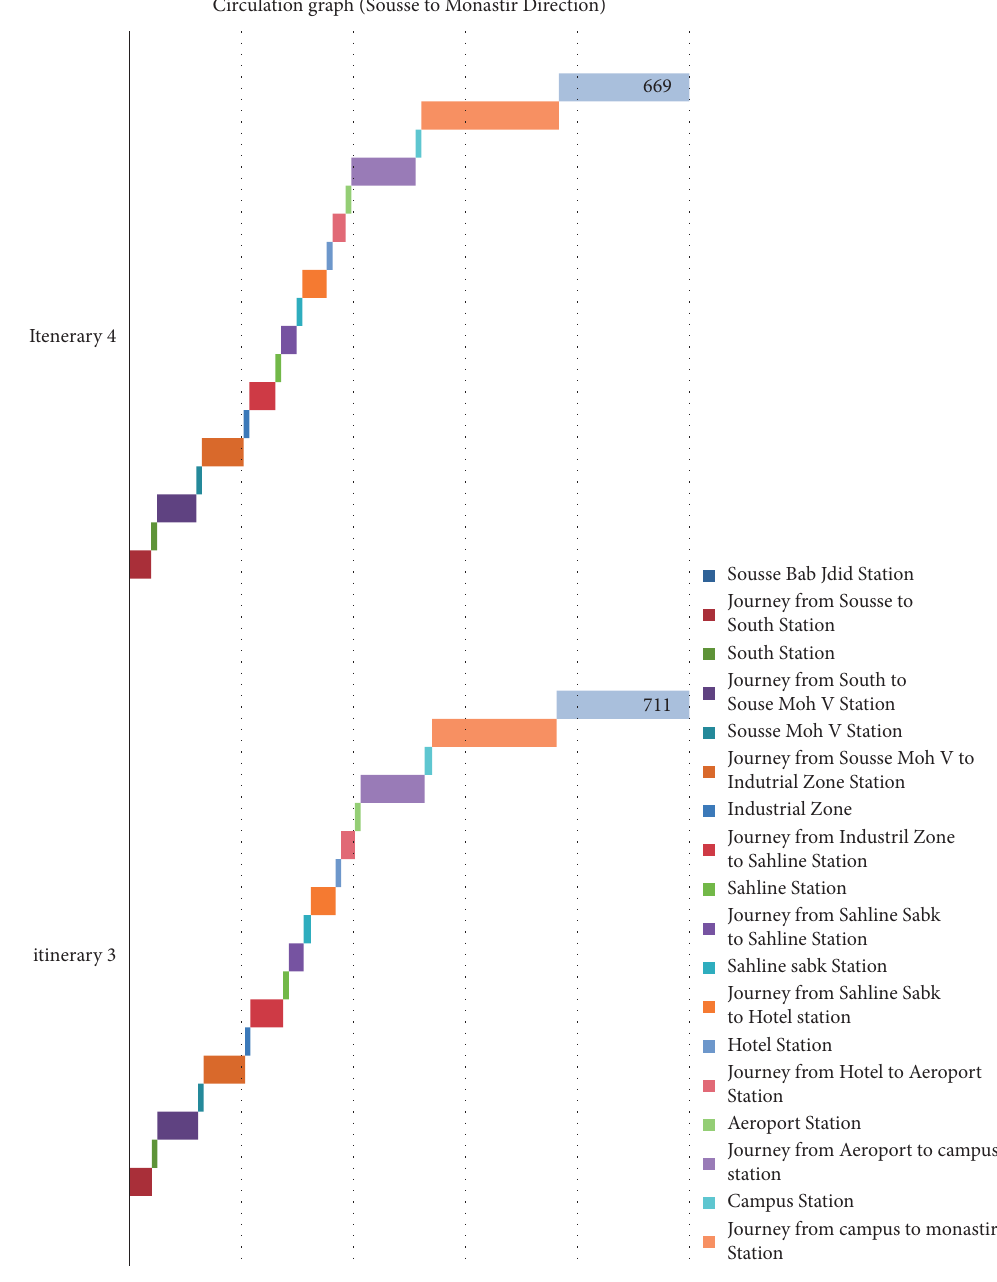
Figure 9: Circulation graph (Sousse to Monastir